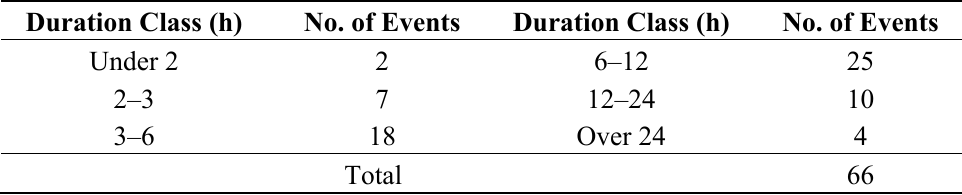
Table 4. Number of the candidate events for different rainfall